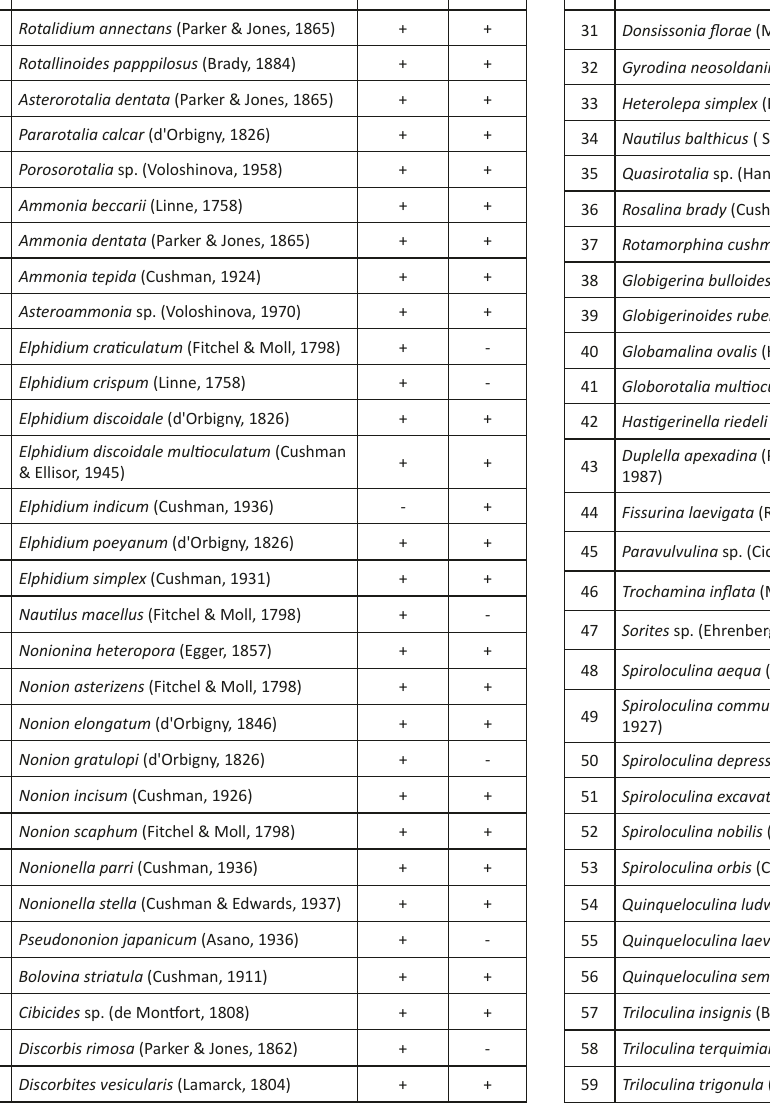
Table 1. List of species of Foraminifera found in sediment cores of Chithrapu and Kumbla